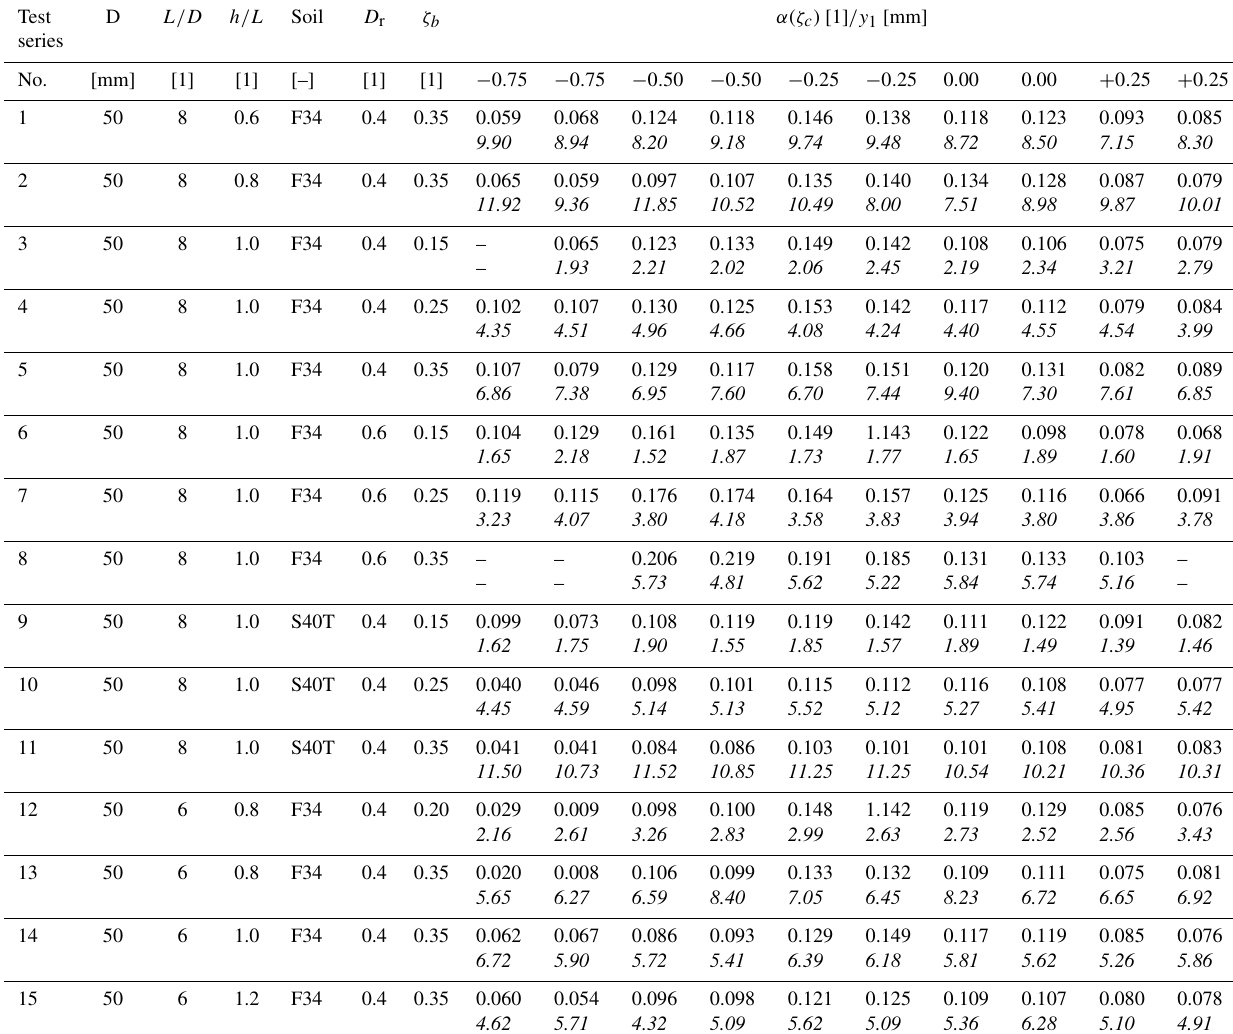
Table 6. Cyclic test results: determined accumulation parameters α ( ζ c ) and measured pile head displacements after first loading ( y 1